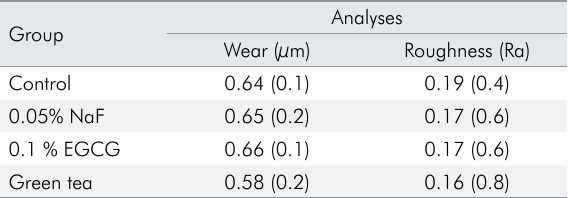
Table. Mean and standard deviation of dentin wear (n = 20) and roughness (n = 20) values found for all the treatments evaluated in the five-day